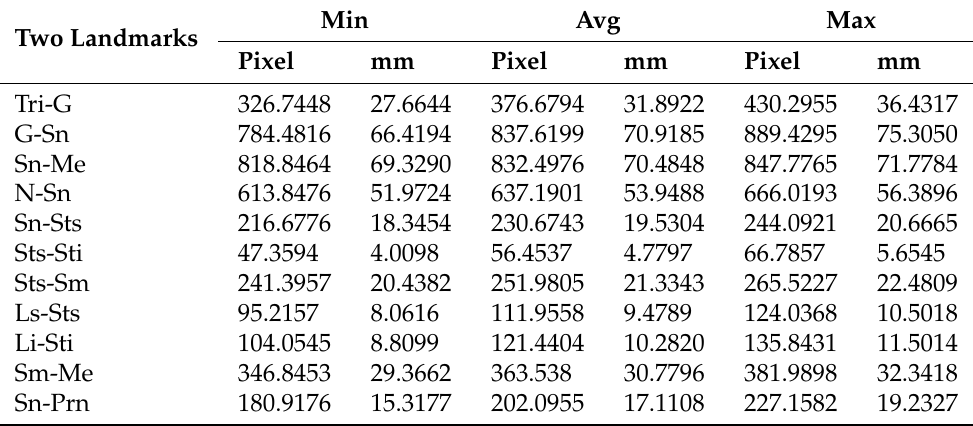
Table 3. Variation of linear measurement.